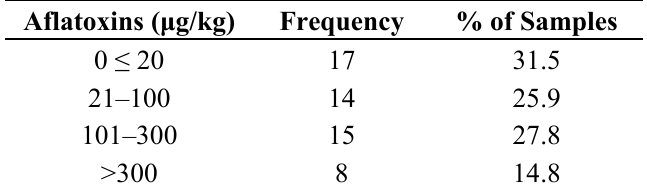
Figure 1. The co-occurrence of mycotoxins in maize kernels sampled in Vietnam. Table 3. Distribution of total aflatoxin levels in maize kernel samples.